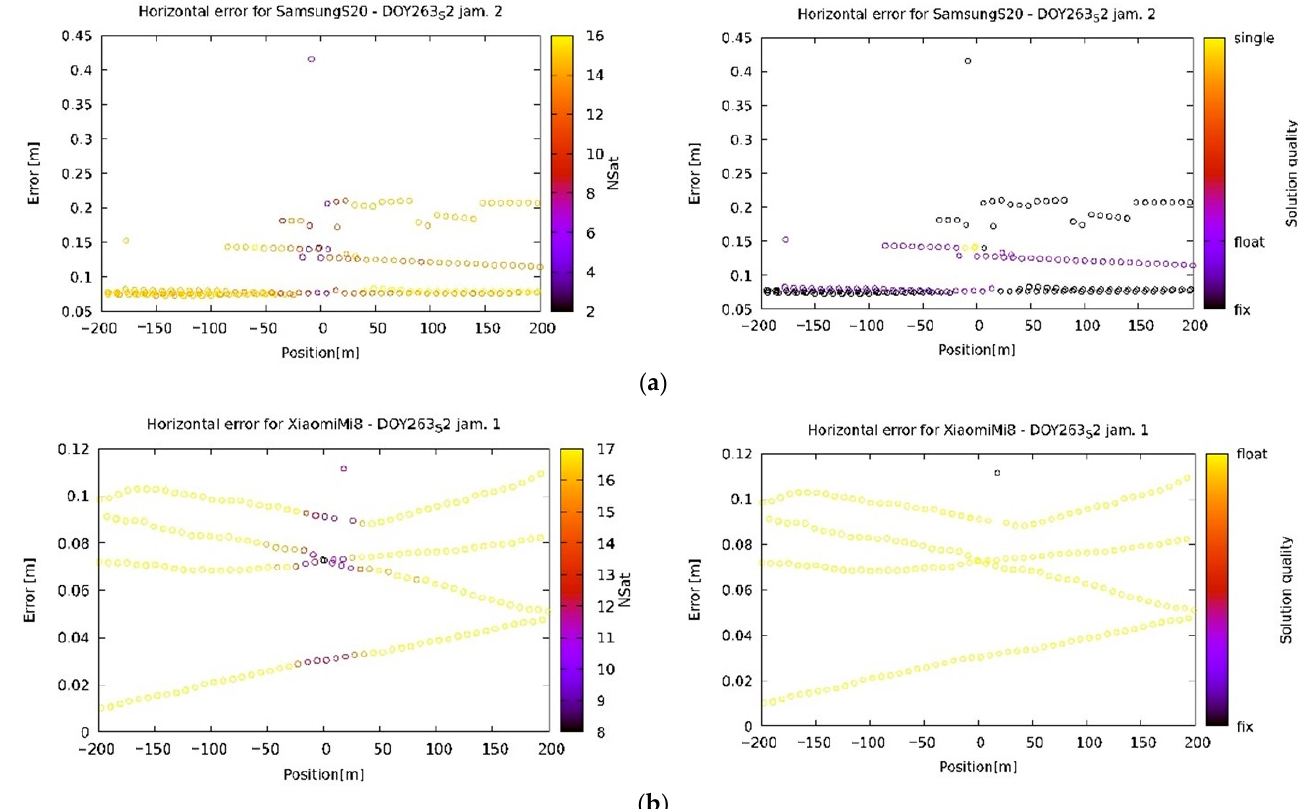
Figure 14. Horizontal accuracy for smartphones. Note the horizontal accuracy deterioration and the smaller number of satellites used in the vicinity of the jammer ( a ). Some phones become completely confused in the presence of the jammer ( b ).